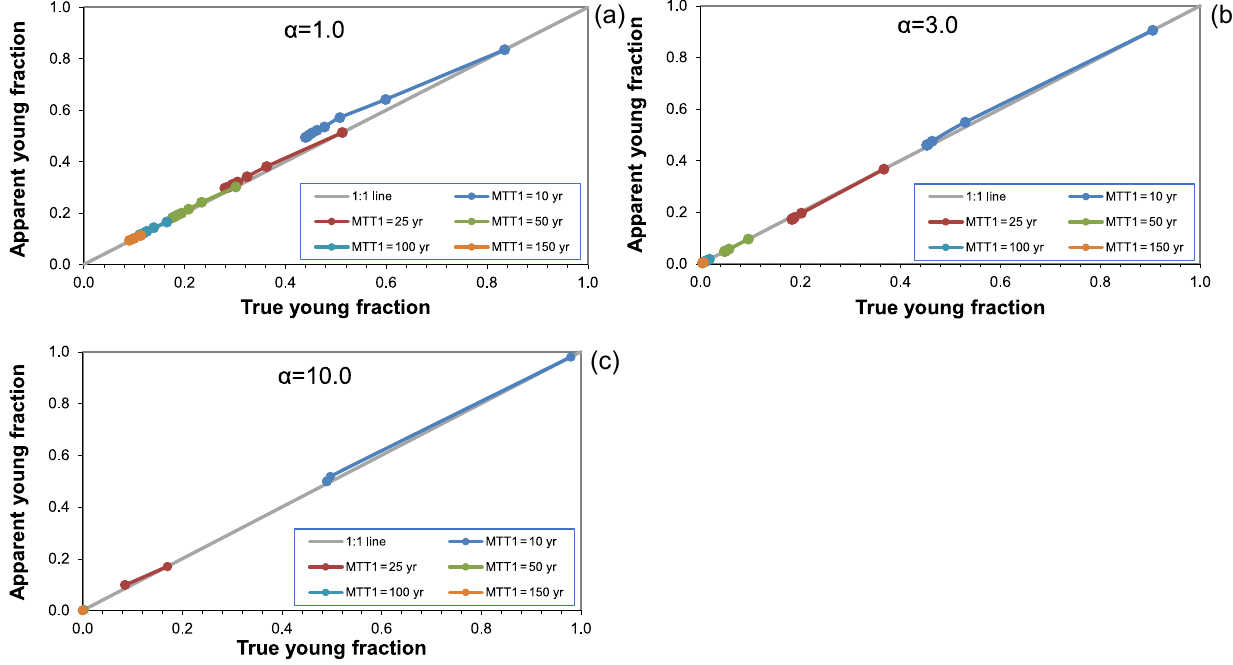
Figure 9. Tritium young water fractions using the Trier, Germany, tritium input function. Symbols as in Fig.